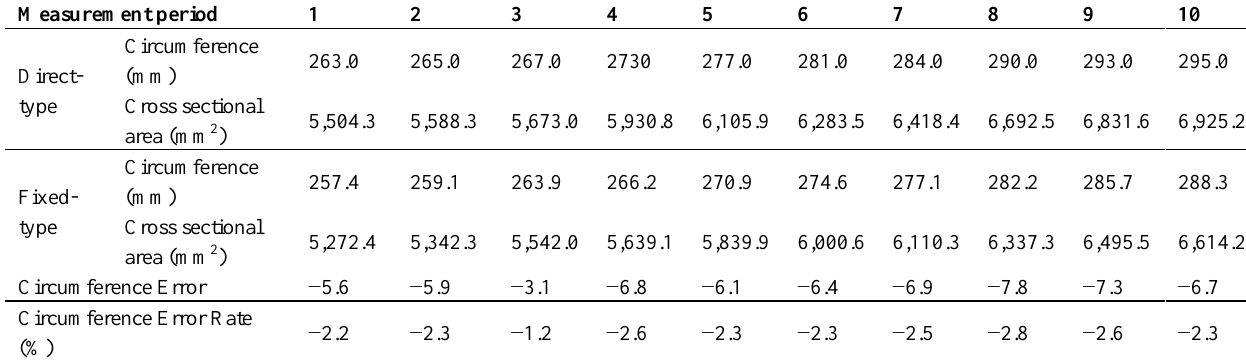
Table 6. Comparisons of measurement results.